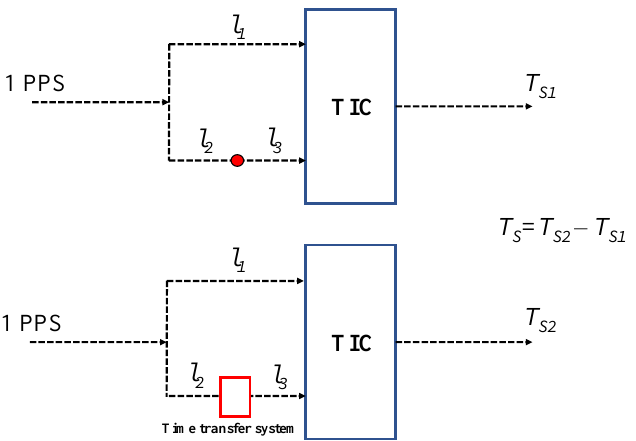
Figure 2. T s measurement method; l 1 is the cable 1 length, l 2 is the cable 2 length, l 3 is the cable 3 length, T s is the system time delay, T s 1 is the system time delay 1, T s 2 is the system time delay 2, and TIC is the time interval